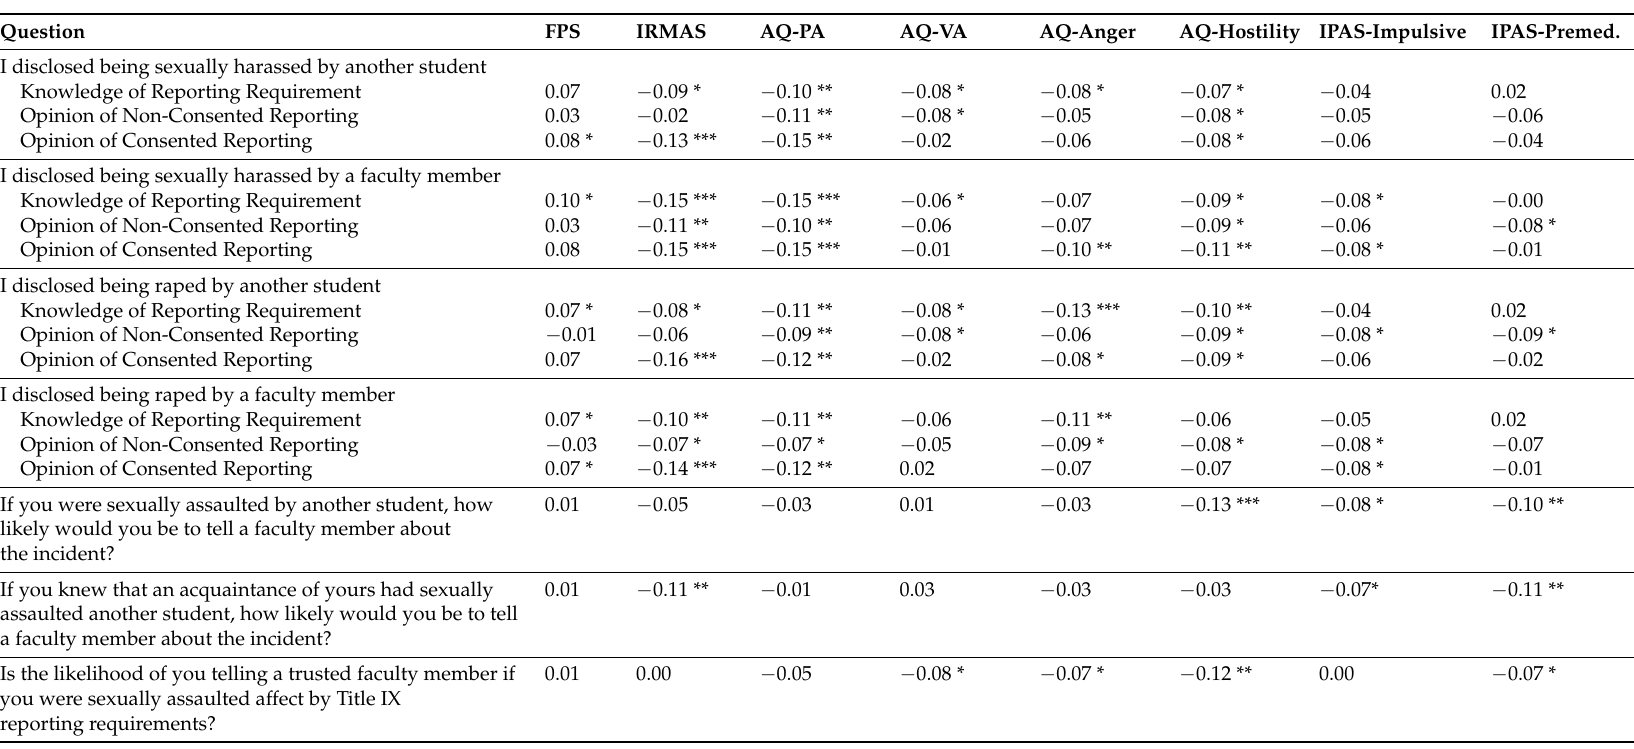
Table 2. Correlations of Title IX questions and reporting likelihood questions with FPS and IRMAS scores (student sample; N = 783).